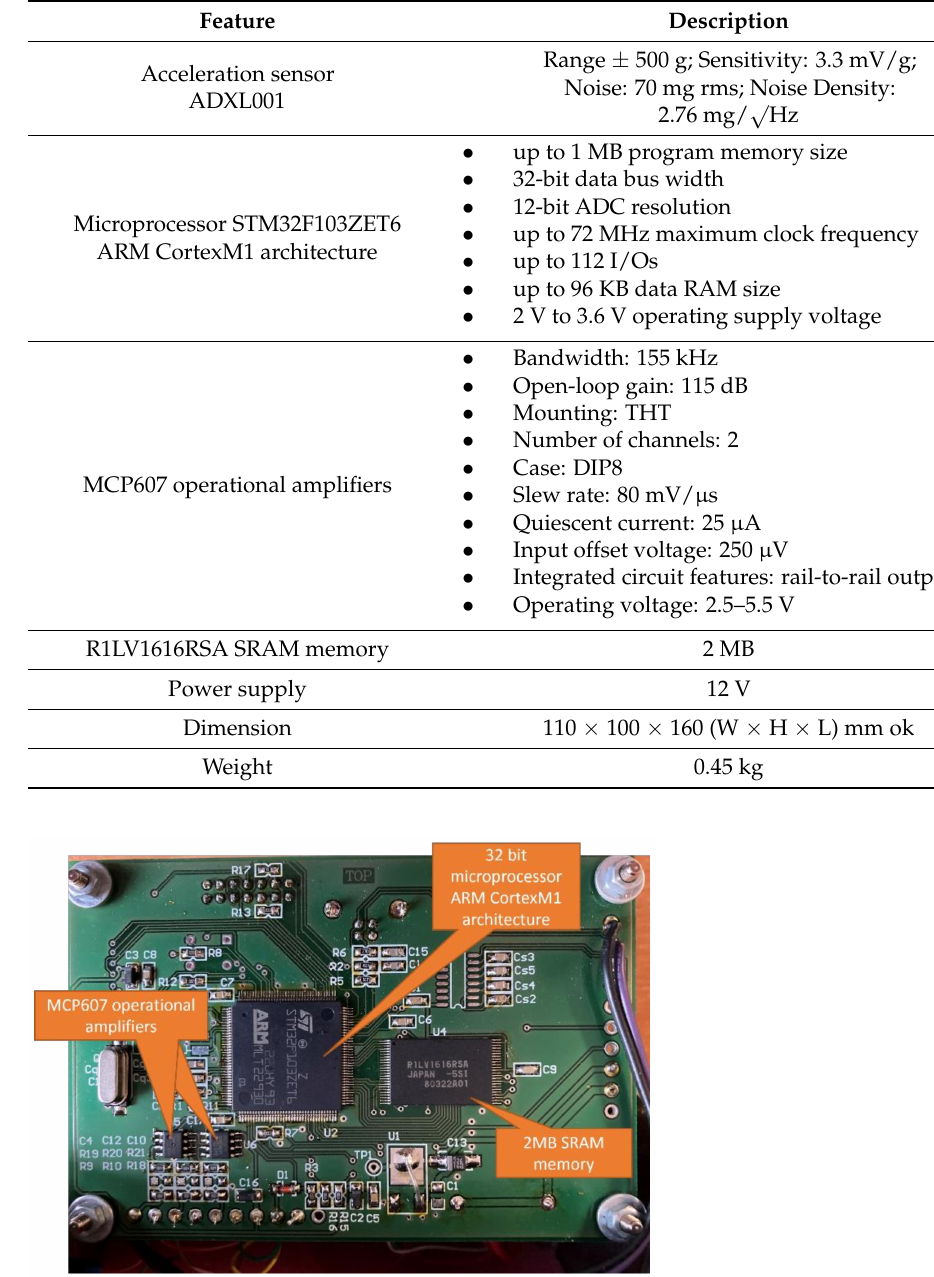
Figure 2. Physical form of the